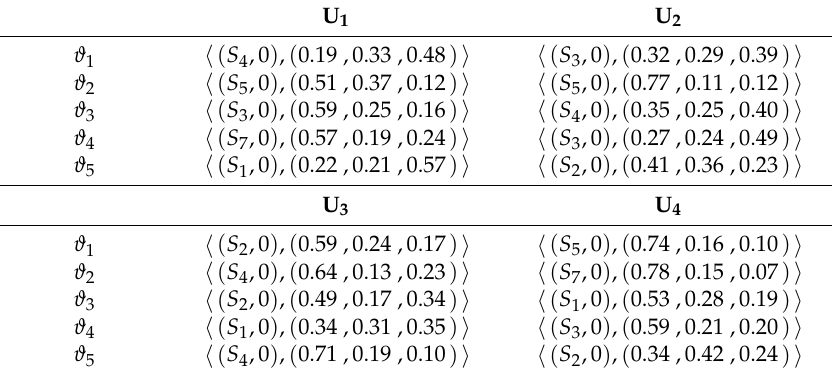
Table 3. Picture 2-tuple linguistic evaluation information by q 3